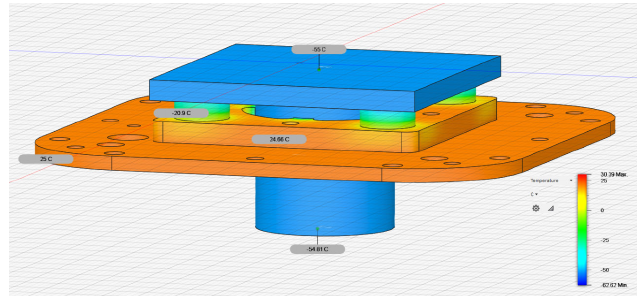
Figure 4. PTFE thermal insulator simulation.